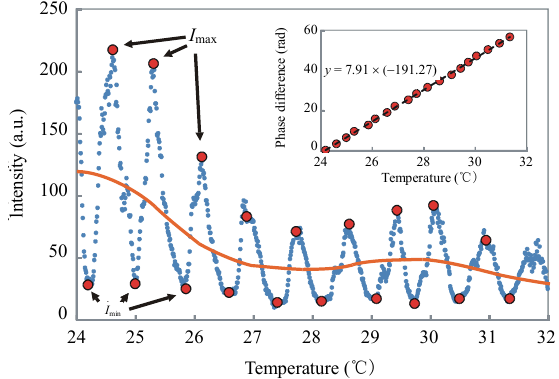
Fig. 3 Output light intensity I out as a function of sample temperature is indicated by blue points. The red points indicate the maxima and minima of constructive or destructive interference, respectively. The orange line indicates the optical coupling detuning due to waveguide position drift during the temperature sweep. The inset shows the calculated phase difference in radians as a function of